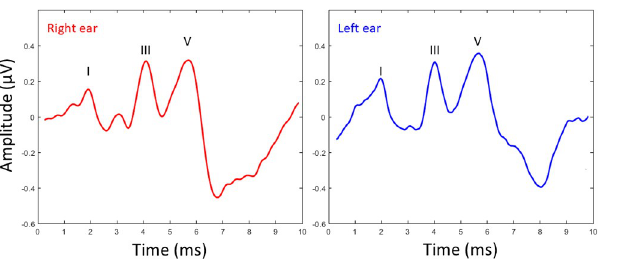
Fig 2. Grand average waveform for the click-ABR obtained from 62 older adults to right (red line) and left (blue line) ear presentation. The stimulus evoked three prominent peaks labeled as I, III and V.